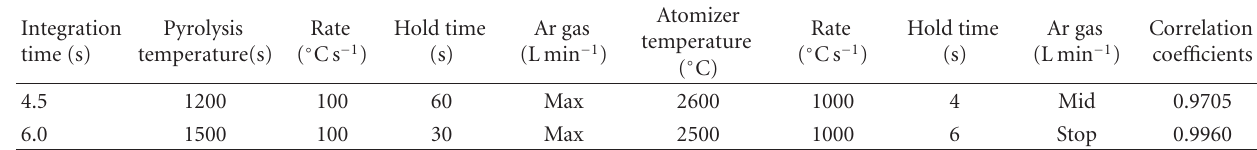
Table 3: Optimization of the furnace program for the analysis of raw coal (liquid sampling